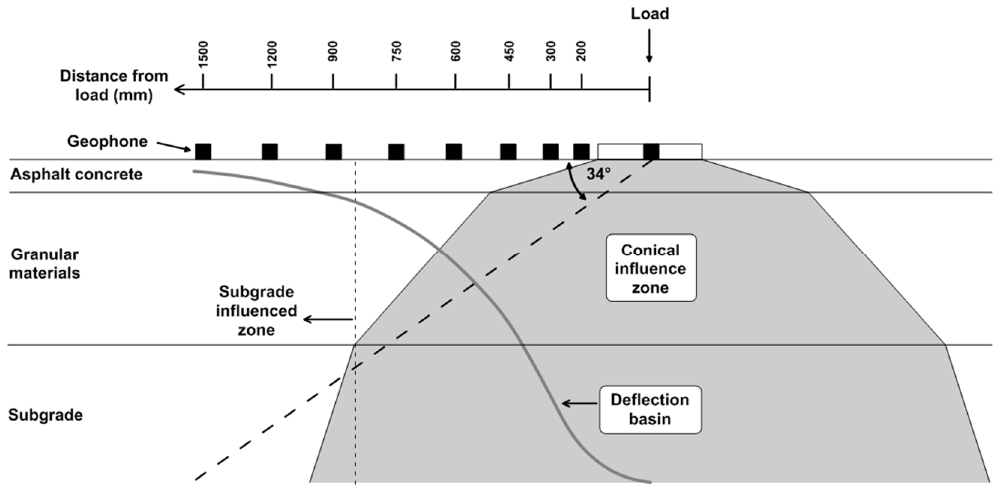
Figure 1. Schematics of the falling weight deflectometer (FWD) test (figure is reproduced from Bilodeau & Doré [31]).